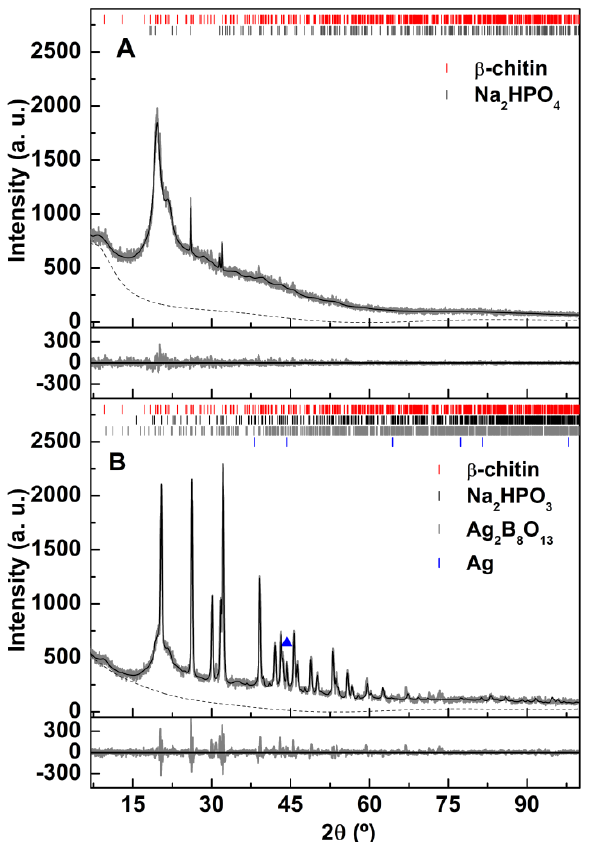
Figure 1. XRD diffractograms of ( A ): CNP; ( B ): CSNP. The silver diffraction peak is labeled with a triangle.